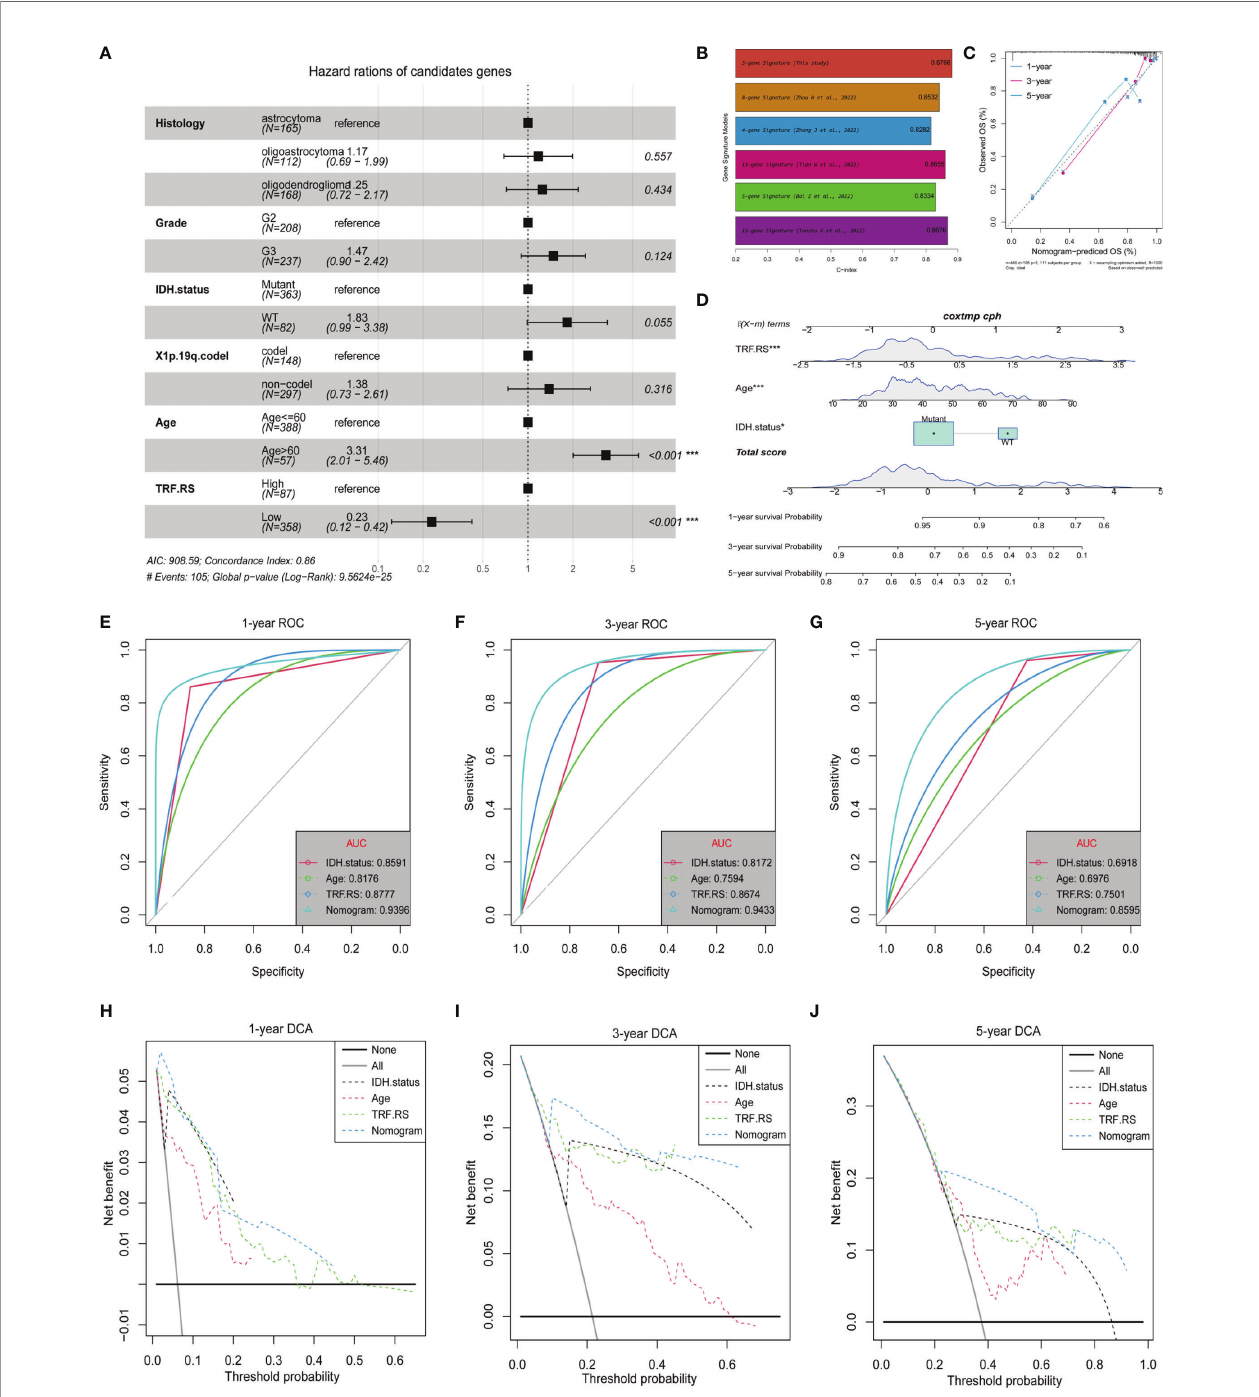
FIGURE 7 | Independent prognostic value of the Tumor Recurrence Factor risk score. (A) Forest plot of multivariate Cox analysis between the Tumor Recurrence Factor risk score and clinical traits. (B) Comparison of the prediction power between this study and other studies. (C) Calibration plot was used to predict the 1-, 3-, and 5-year survival in TCGA-LGG cohorts. (D) Nomogram of TCGA-LGG cohorts was used to predict overall survival. (E – G) Receiver operating characteristic (ROC) curves showed the 1-, 3-, and 5-year predictive ef fi ciency of risk score, age, IDH mutation status, and nomogram model. (H – J) Decision curve analysis (DCA) curves showed the 1-, 3-, and 5-year predictive ef fi ciency of risk score, age, IDH mutation status, and nomogram model. "*" means 0.01<p<0.05, "***"means